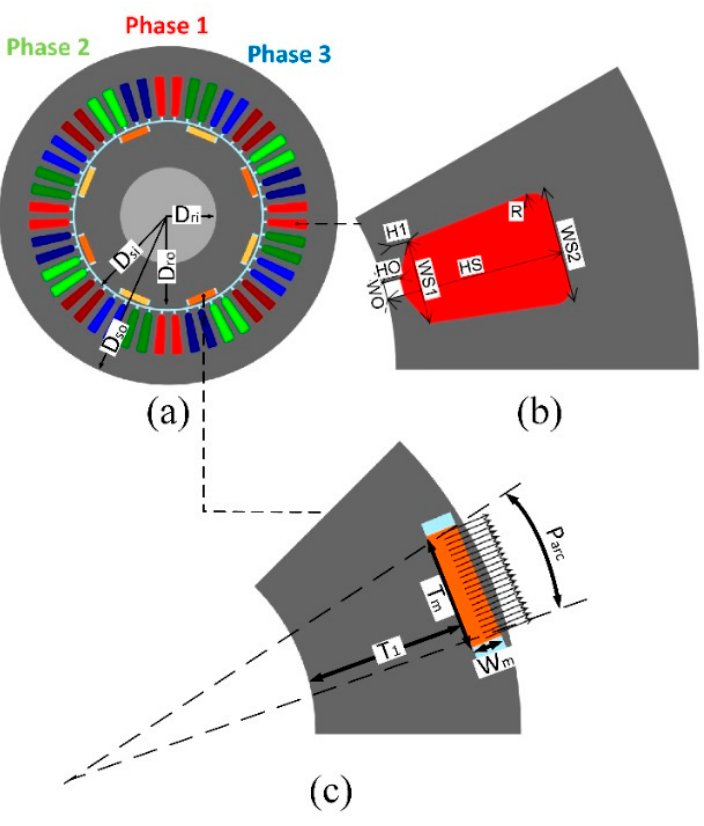
Figure 1. ( a ) Three-phase winding distribution in the stator core, ( b ) slot dimensions, and ( c ) rotor parameters.